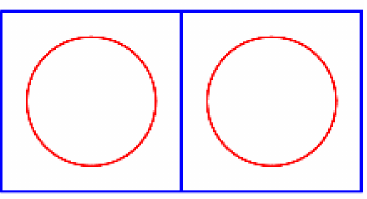
Figure 3. CTF and FLOCAL 2 × 1